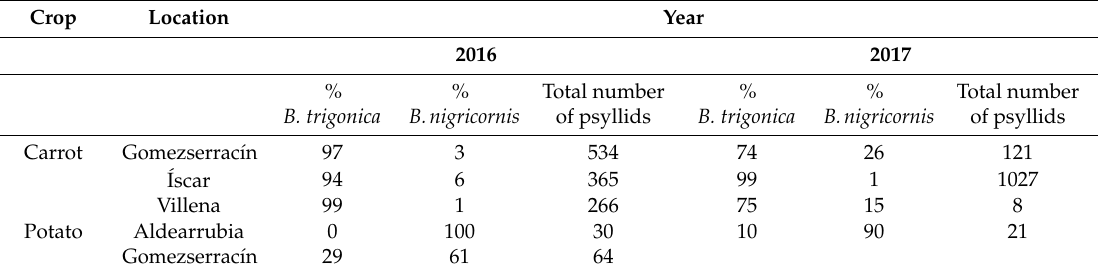
Table 4. Percentage of psyllid species in horizontal green tile water traps in carrot and potato fields surveyed in 2016 and